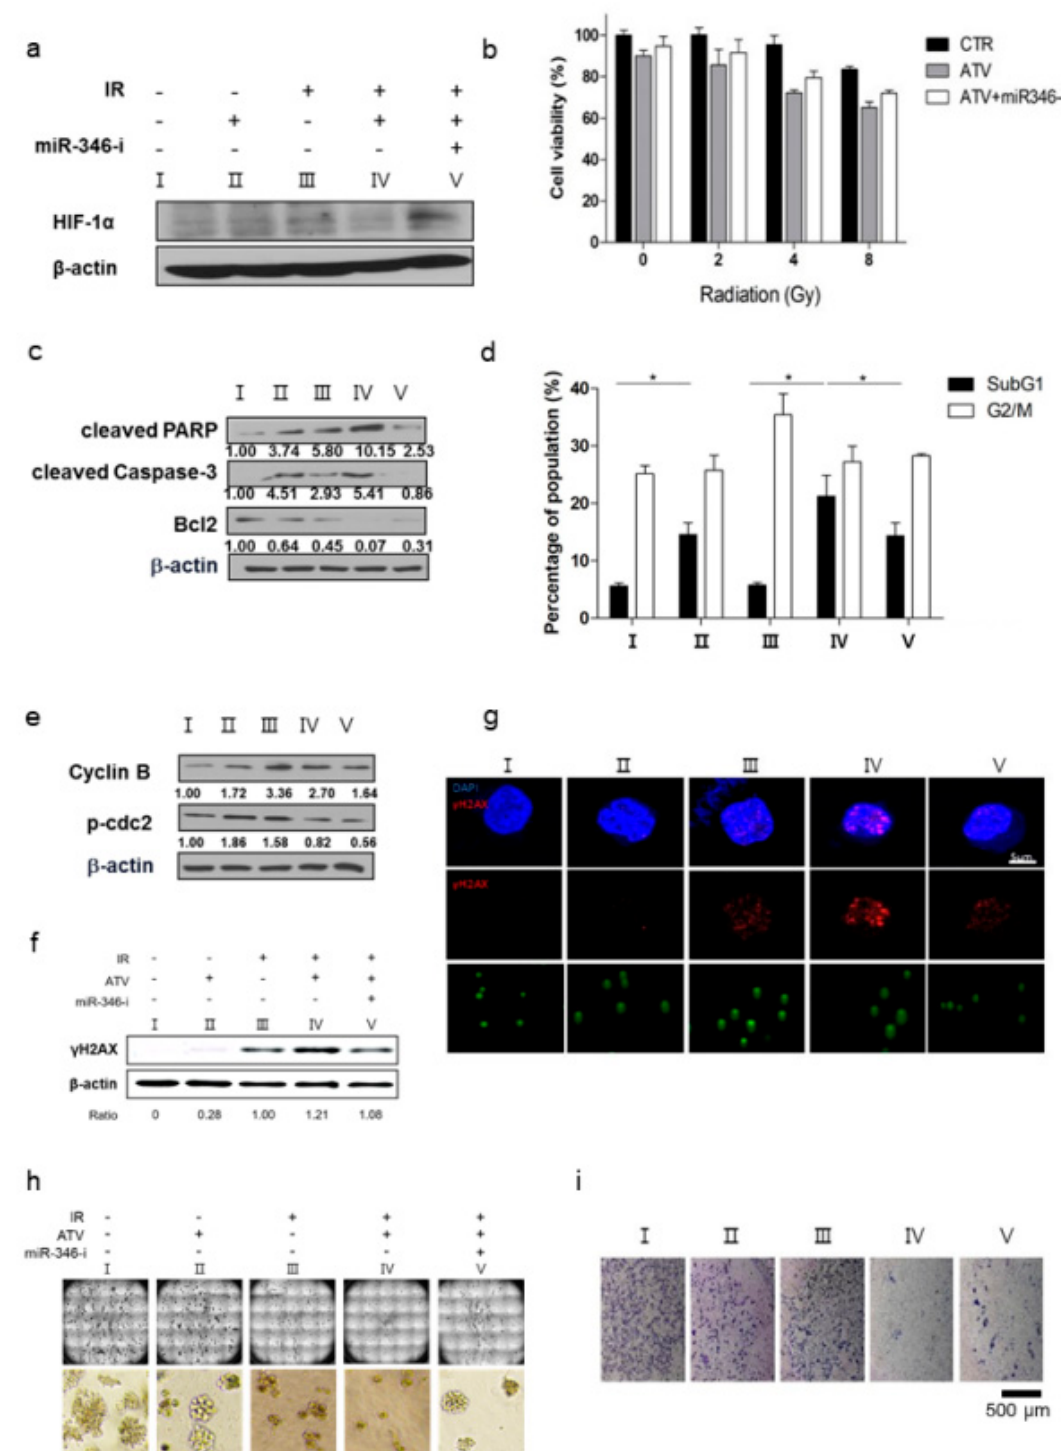
Figure 6. Atorvastatin and miR-346 regulated the radiosensitivity of Raji cells. ( a ) The cell lysates were immunoblotted with the indicated antibodies after atorvastatin and radiation and miR-346 inhibitor treatment (* p < 0.05). ( b ) The cell viability was measured by CCK8-assay in Raji cells treated with atorvastatin and / or miR-346-inhibitor under 2, 4, and 8 Gy irradiation. ( c ) Cell lysates were immunoblotted with the indicated antibodies. ( d ). Cell cycle analysis was conducted by PI-staining in each group at 24 h after IR (* p < 0.05). The data are the mean ± SD from three independent groups.